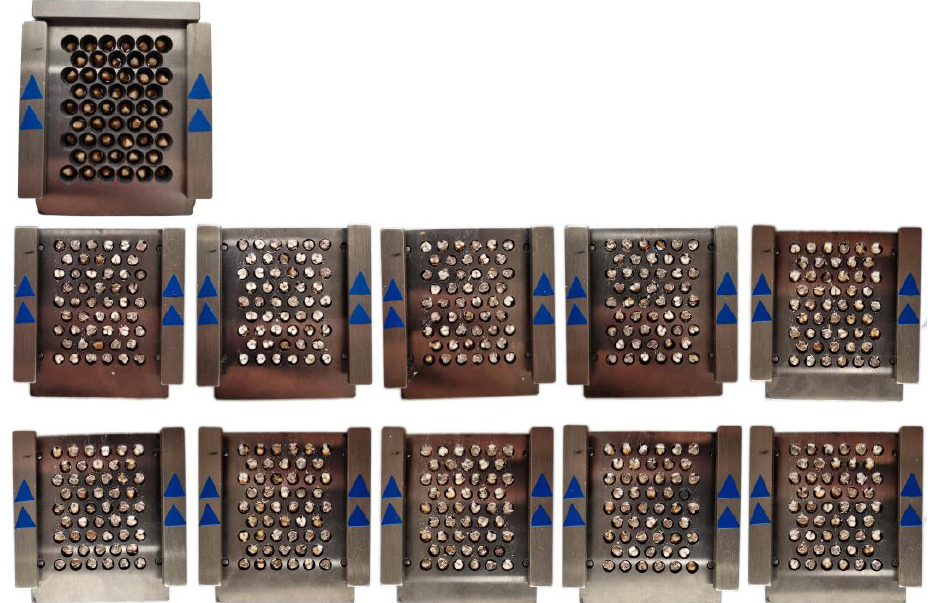
Figure 12. Cuts of the 10 wheat varieties with commercial available grain cutter (standard knife).